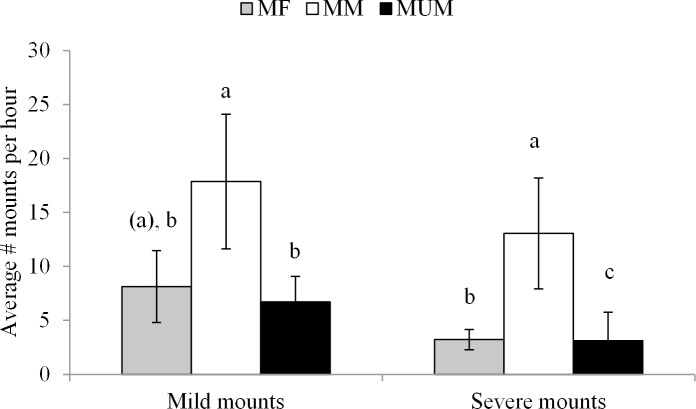
Average number of mounts (mild ≤ 3 sec, severe > 3 sec) per hour measured during holding and lairage for each treatment (MF = mixed with females, MM = mixed with males, MUM = unmixed males).Different letters indicate significant differences (P < 0.05), letters within brackets tend to be different from the same letter without brackets (0.05 ≤ P ≤ 0.1).